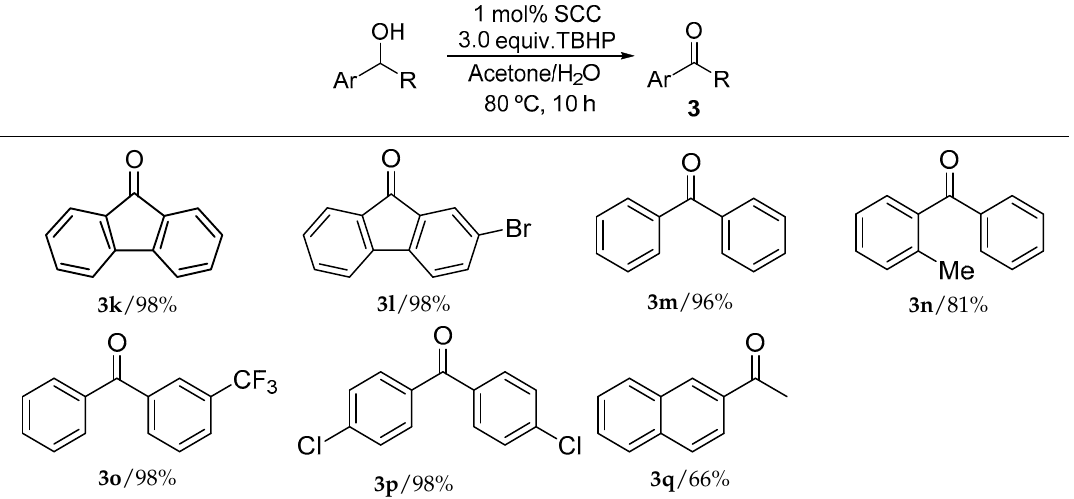
Table 4. The oxidation of secondary alcohols catalyzed by SCC a .